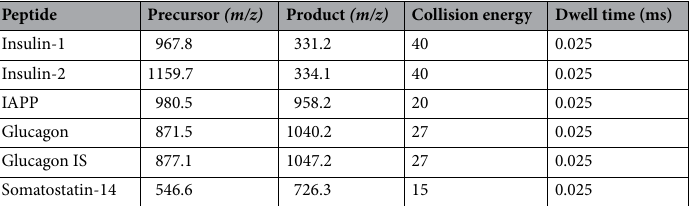
Table 1. Parameters of LC–MS/MS analysis. Precursor and precursor ions along with collision energies and dwell time used to monitor each peptide during LC–MS/MS